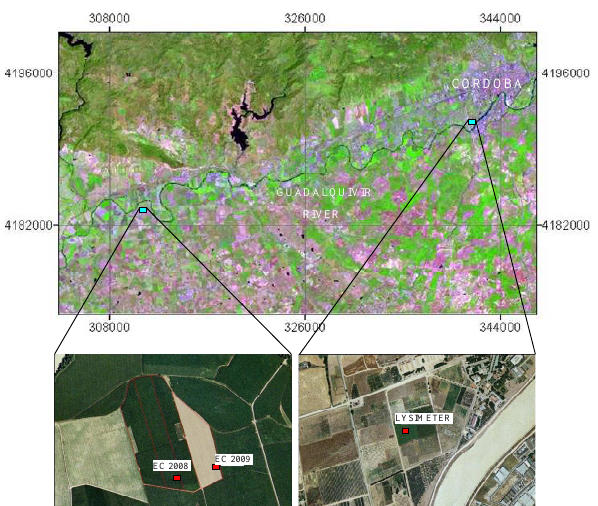
Fig.1 A mid-infrared (band 5), near-infrared (band 4) and red (band 3) composite of the Landsat TM-5 image (3 May 2009; DOY 123) and a high resolution ortho-photograph (2004) showing the fields that contained the eddy covariance (EC) flux stations (2008 and 2009) and the weighing lysimeter (2009).